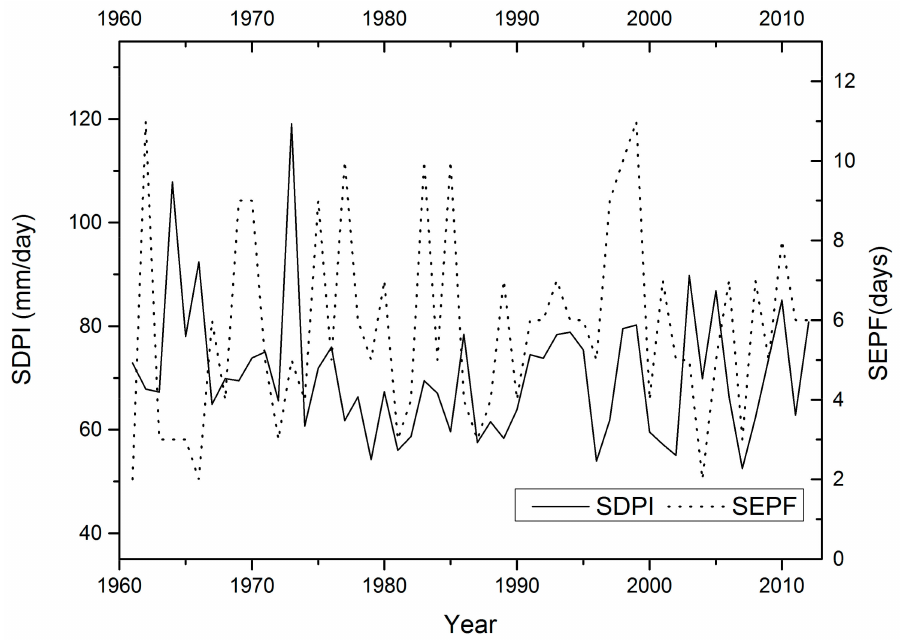
Figure 12. Interannual variations of SDPI and SEPF at the Nanchang station in Dongting-Changjiang area from 1961 to